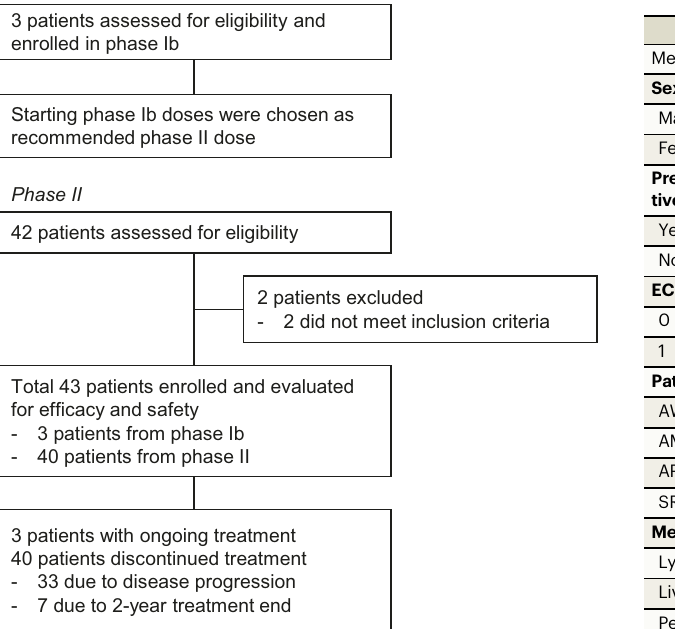
Table 1 | Baseline patient characteristics ( n =